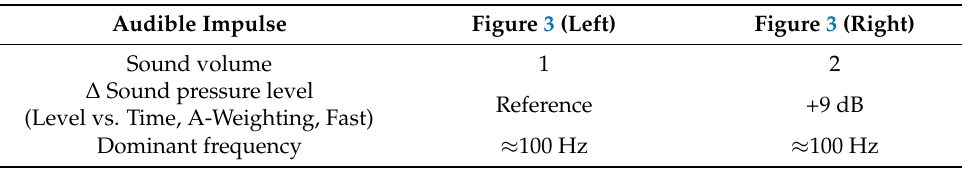
Table 2. Parameters of the audible